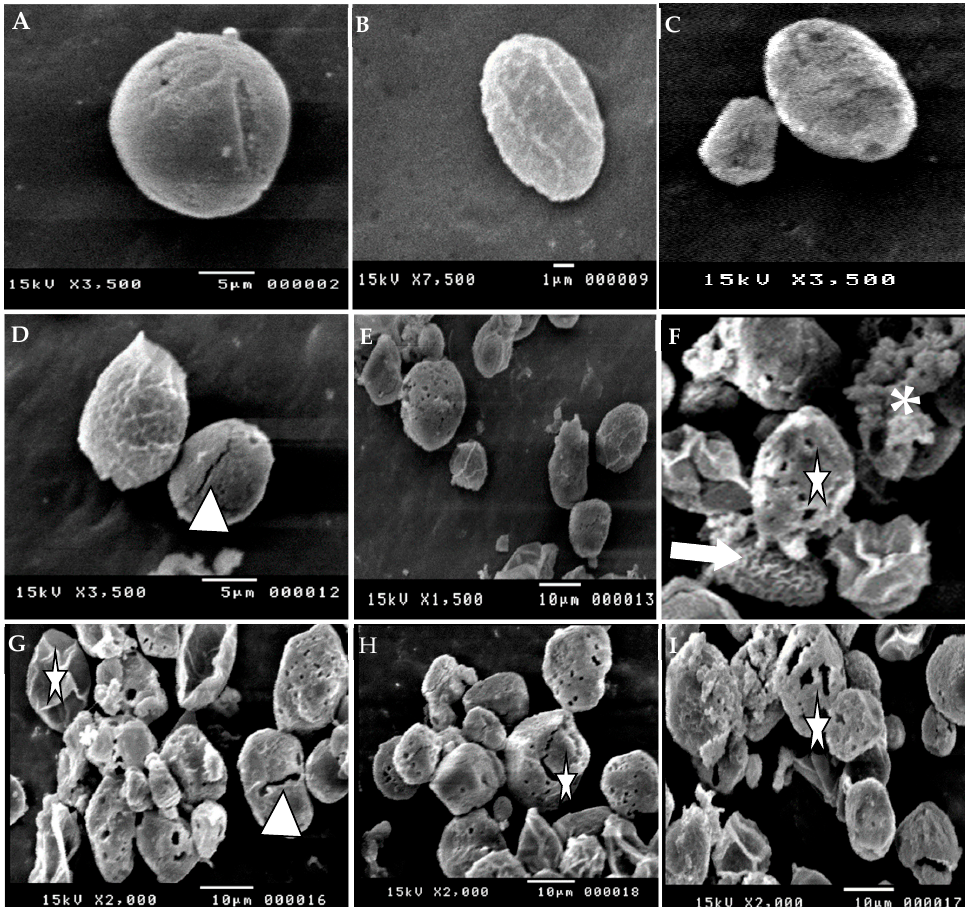
Figure 3. Scanning electron micrograph of E. tenella oocysts undergoing sporulation in the presence of allicin and alcoholic garlic extract, 48 h post-incubation. ( A – C ) Oocysts in untreated controls were spherical and intact. Allicin and Alcoholic garlic extract-treated oocysts exhibited. ( D , E ) Irregular oocysts shape, oocyst walls roughness that became fractured at specific areas (ow, arrowhead). ( F ) Broken non-sporulated oocyst exposing its cytoplasm with distorted amylopectin granules throughout (asterisk). ( G – I ) Oocyst lost its wall during early cytokinesis (star). Note the empty oocyst wall (arrowhead) resulting from the destruction of sporocysts and the collapse/shrinking of some oocysts due to the lysis of their contents, ×3500.